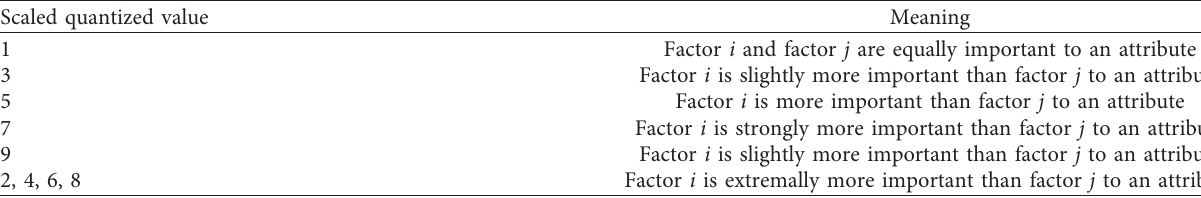
Table 1: Scale table of importance judgment.